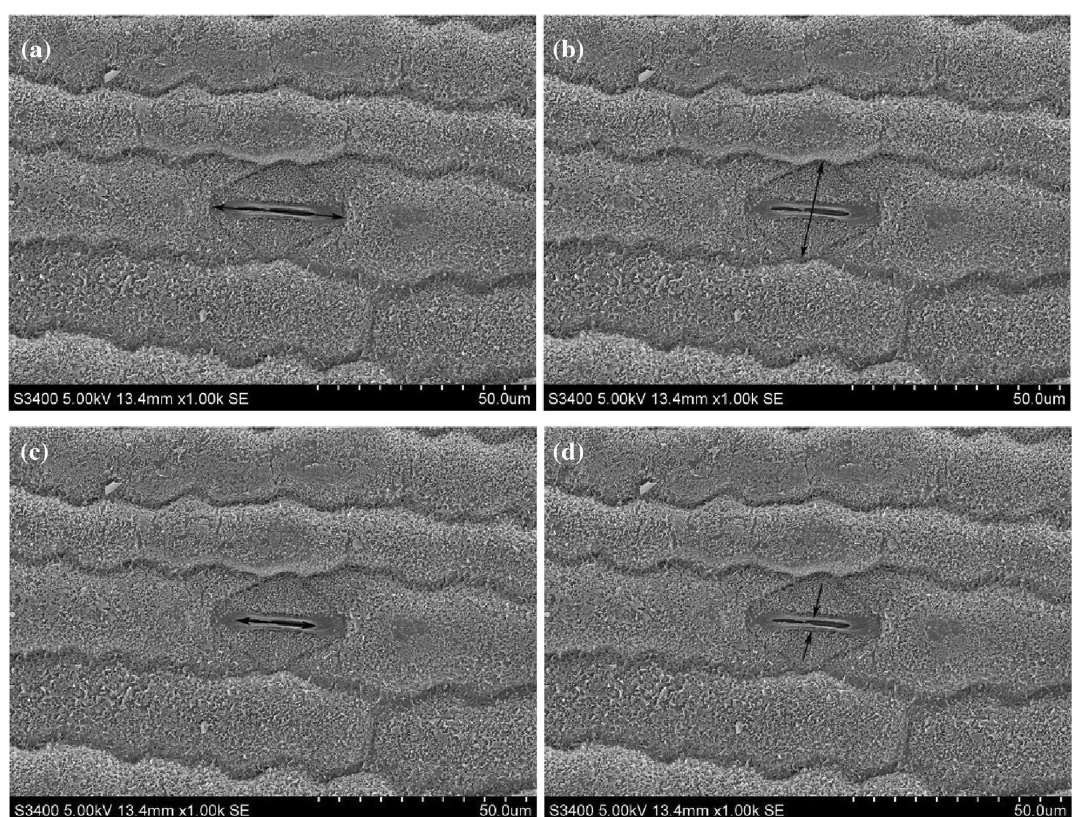
Figure 7. Measurement of stomatal length ( a ), width ( b ), aperture length ( c ) and width ( d